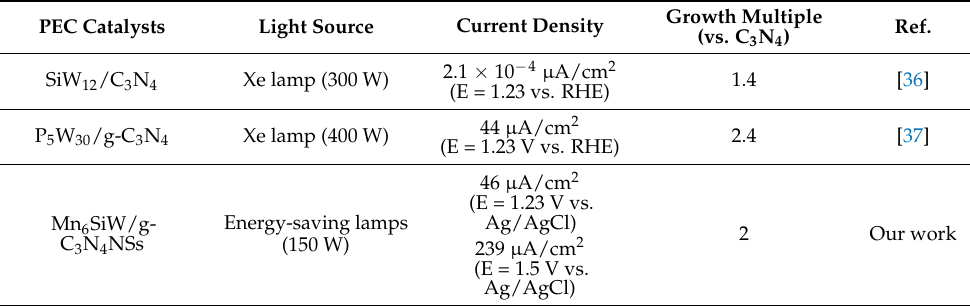
Table 3. Reported polyoxometalate modified C 3 N 4 catalysts used to catalyze water